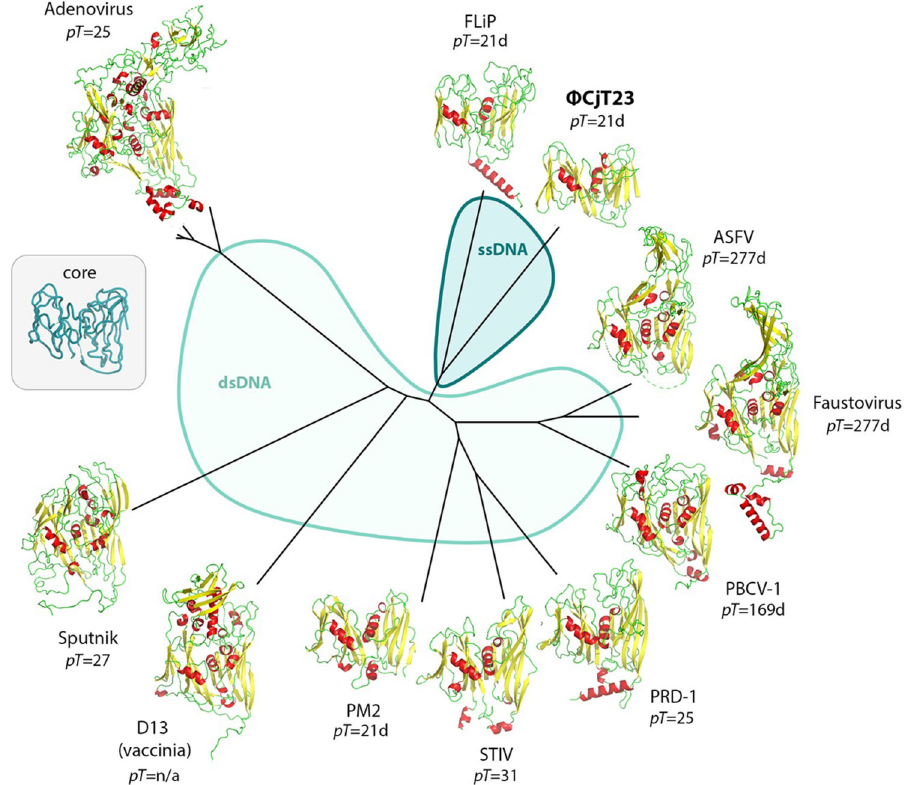
Fig. 3 | Structural phylogeny of major capsid proteins with double jelly-roll fold. Thetwodifferentpartsofthephylogeny,correspondingtovirusesharboring eitheranssDNA(blue)ordsDNA(lightblue)genome,areshownindifferentcolors.